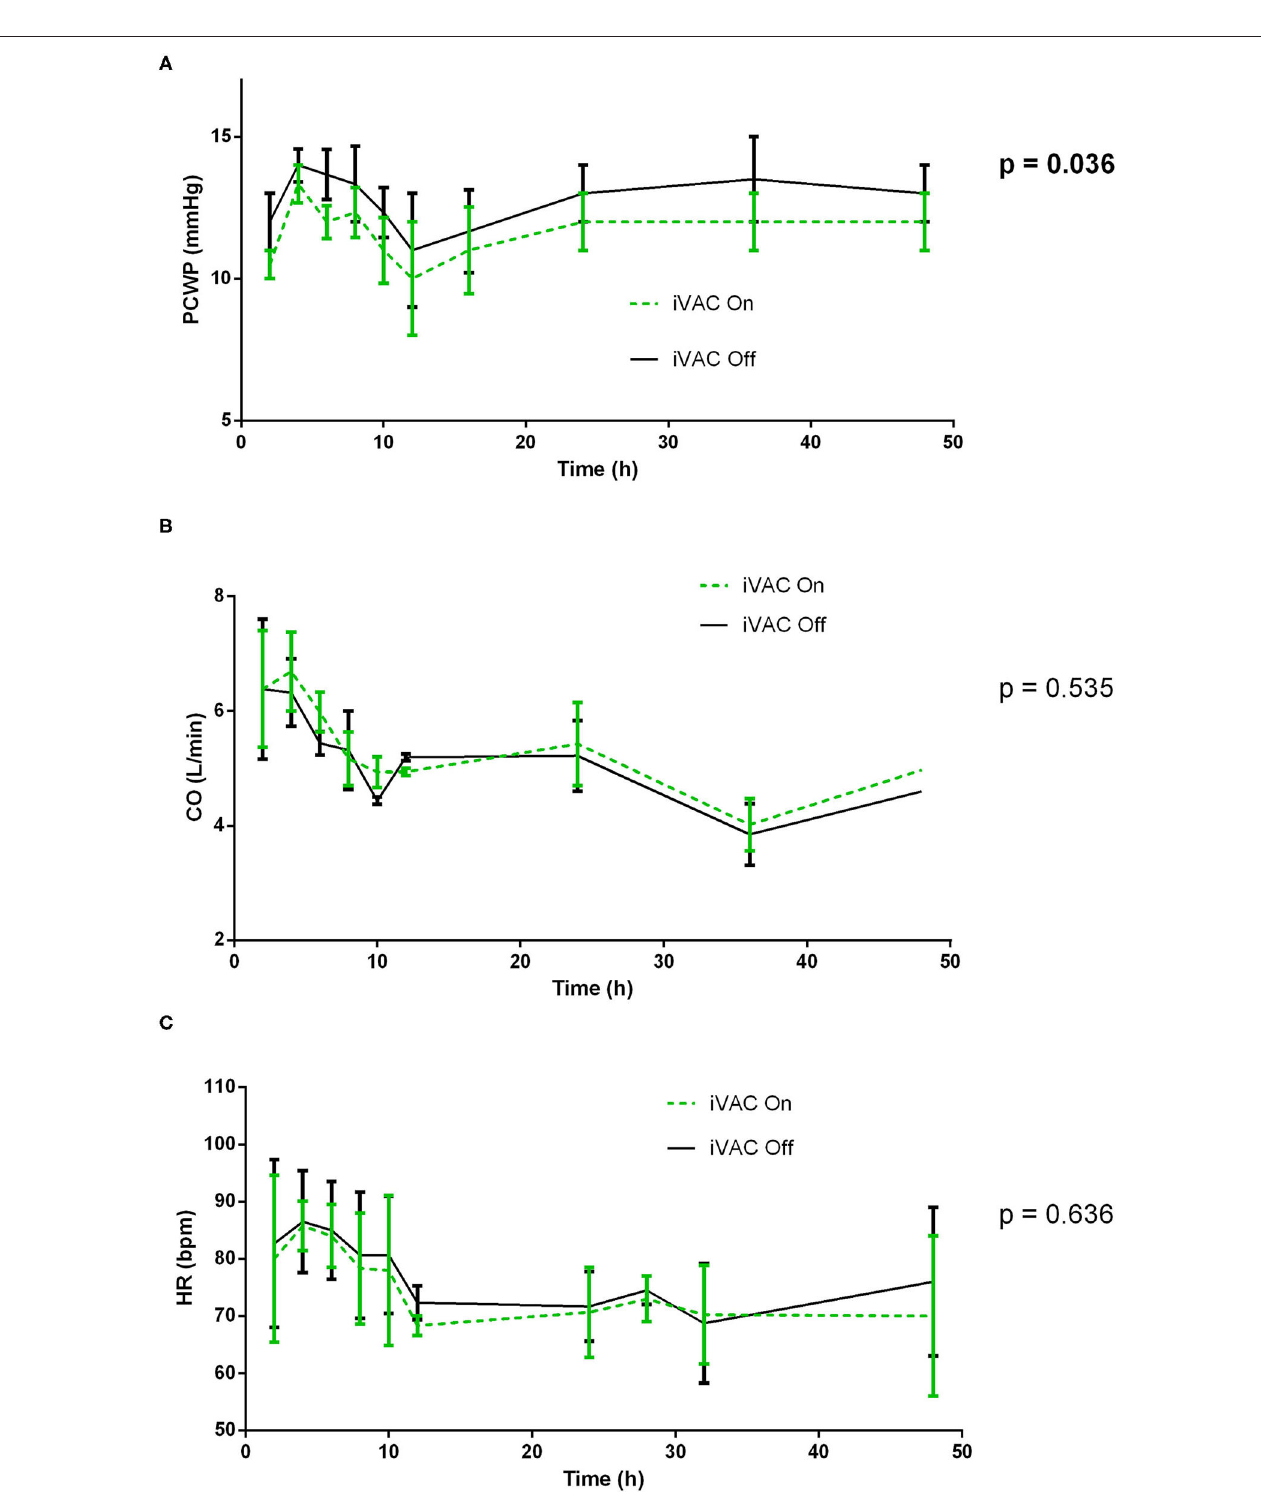
FIGURE 1 | Comparative analysis of pulmonary wedge pressure (A) , cardiac output (CO) (B) , and heart rate (C) with and without IVAC2L support in healthy pigs. At different times (H0, H2, H4, H6, H8, H10, H12, H16, H24, H36, and H48), the IVAC2L support was deactivated by turning Off the extra-corporal pump during 5min and then, reactivated until next time point. Invasive and non-invasive hemodynamic parameters were recorded throughout the procedure and until 48h. Parameters are presented at each time points by mean ± SEM ( n = 6). The values of p were obtained by comparing On and Off values for each parameter. CO, cardiac output; HR, heart rate; PCWP, pulmonary capillary wedge pressure; SEM, standard error of mean.